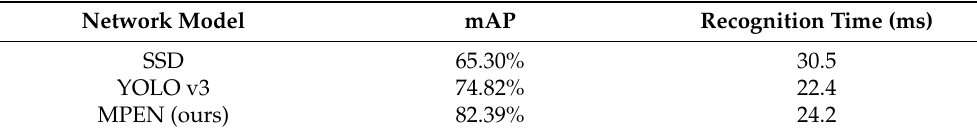
Table 1. Comparison of target recognition performance in millimeter wave images by each network.